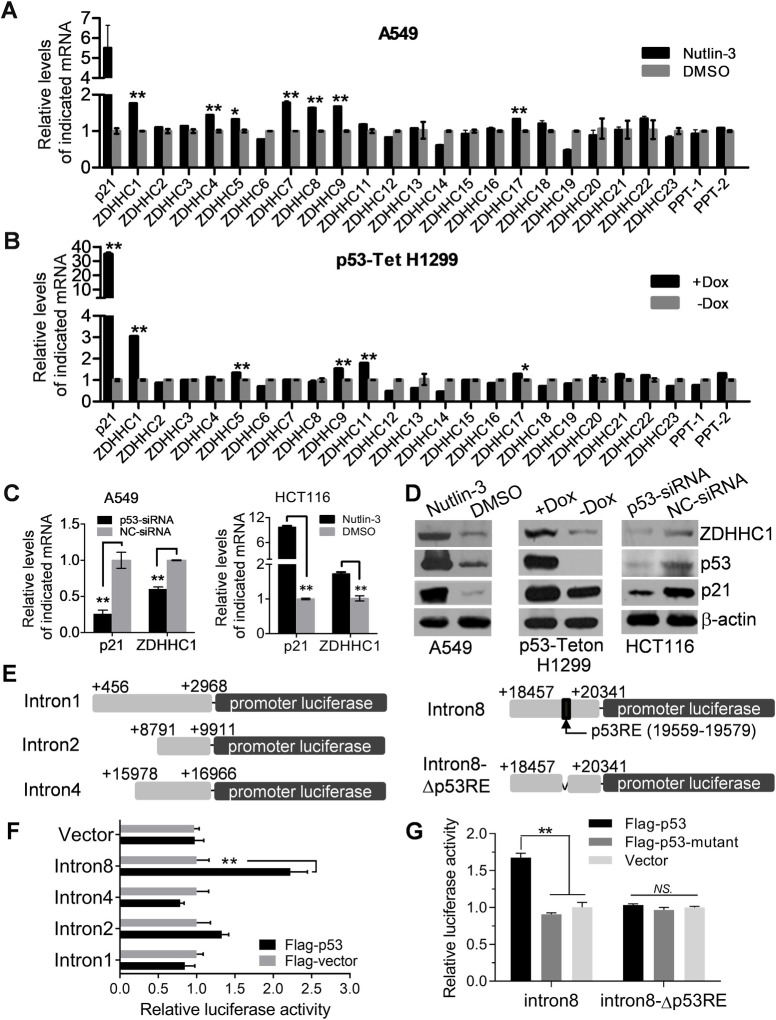
Up-regulation of ZDHHC1 expression induced by p53.(A and B) A549 cells were treated with 20 μM Nutlin-3 for 24 h (A) or p53-Teton H1299 cells were treated with 1 μg/ml Dox (+Dox) for 24 h (B), the relative mRNA levels of the indicated ZDHHCs, PPT-1, PPT-2 and p21 were determined by qRT-PCR. (C) A549 cells were treated with 150 nM p53-siRNA for 48 h or HCT116 cells were treated with 20 μM Nutlin-3 for 24 h, the relative mRNA abundance of ZDHHC1 and p21 were determined by qRT-PCR. (D) A549 cells were treated with 20 μM Nutlin-3 for 24 h, p53-Teton H1299 cells were treated with 1 μg/ml Dox (+Dox) for 24 h, HCT116 cells were transfected with 150 nM p53-siRNA for 48 h, protein expression of p53, ZDHHC1 and p21 in above cells were detected by western blot. (E) Schematic representation of the construction of pGL3-promoter luciferase reporter plasmids. (F and G) A549 cells were transfected with a combination of the indicated plasmids and incubated for 24 h. Luciferase activities of the transfectants were analyzed and presented relative to the activity in cells transfected with the Flag-vector (set as 1). Unpaired t test, *P<0.05; **P<0.01.